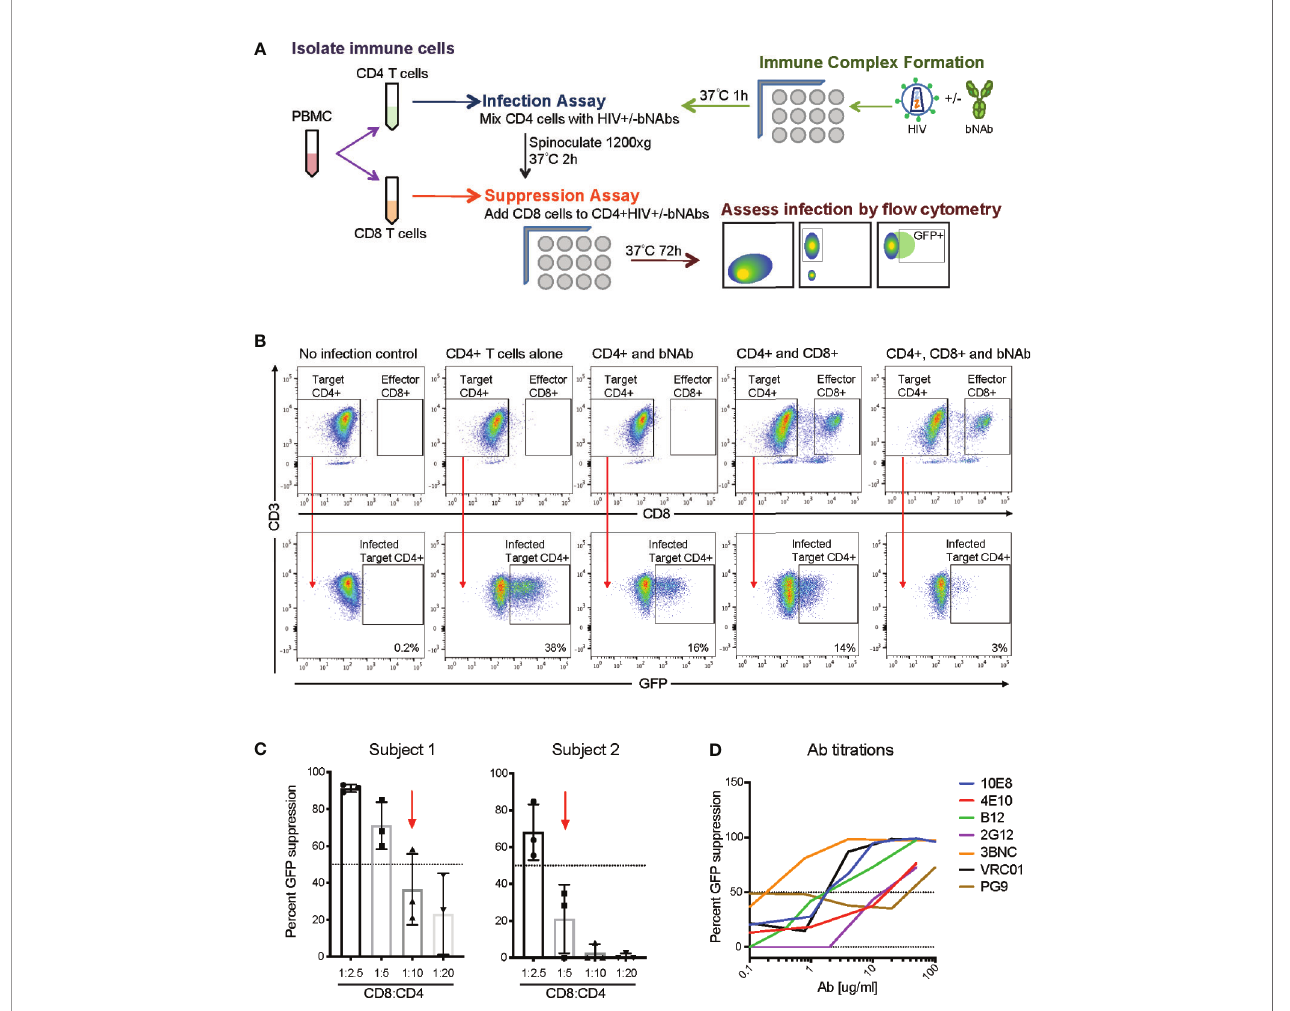
FIGURE 1 | Overview of bNAb+CD8 suppression assay experimental scheme. (A) A schematic of the overall assay design and analysis. (B) Representative FACS plots demonstrating CD4 gating and GFP+ gating in the negative control (no infection), positive control (CD4 T cells alone), and experimental conditions (CD4 and bNAb; CD4 and CD8; CD4, CD8 and bNAb), GFP+ percentages shown. (C) Displays the E:T ratios used for two representative subjects to show how E:T ratios were chosen for each individual studied, CD8:CD4 ratios which resulted in less than 60% GFP suppression were used for suppression and Bliss analyses. (D) Representative data of bNAb titrations completed to calculate IC50 concentrations for each bNAb to be used in the suppression